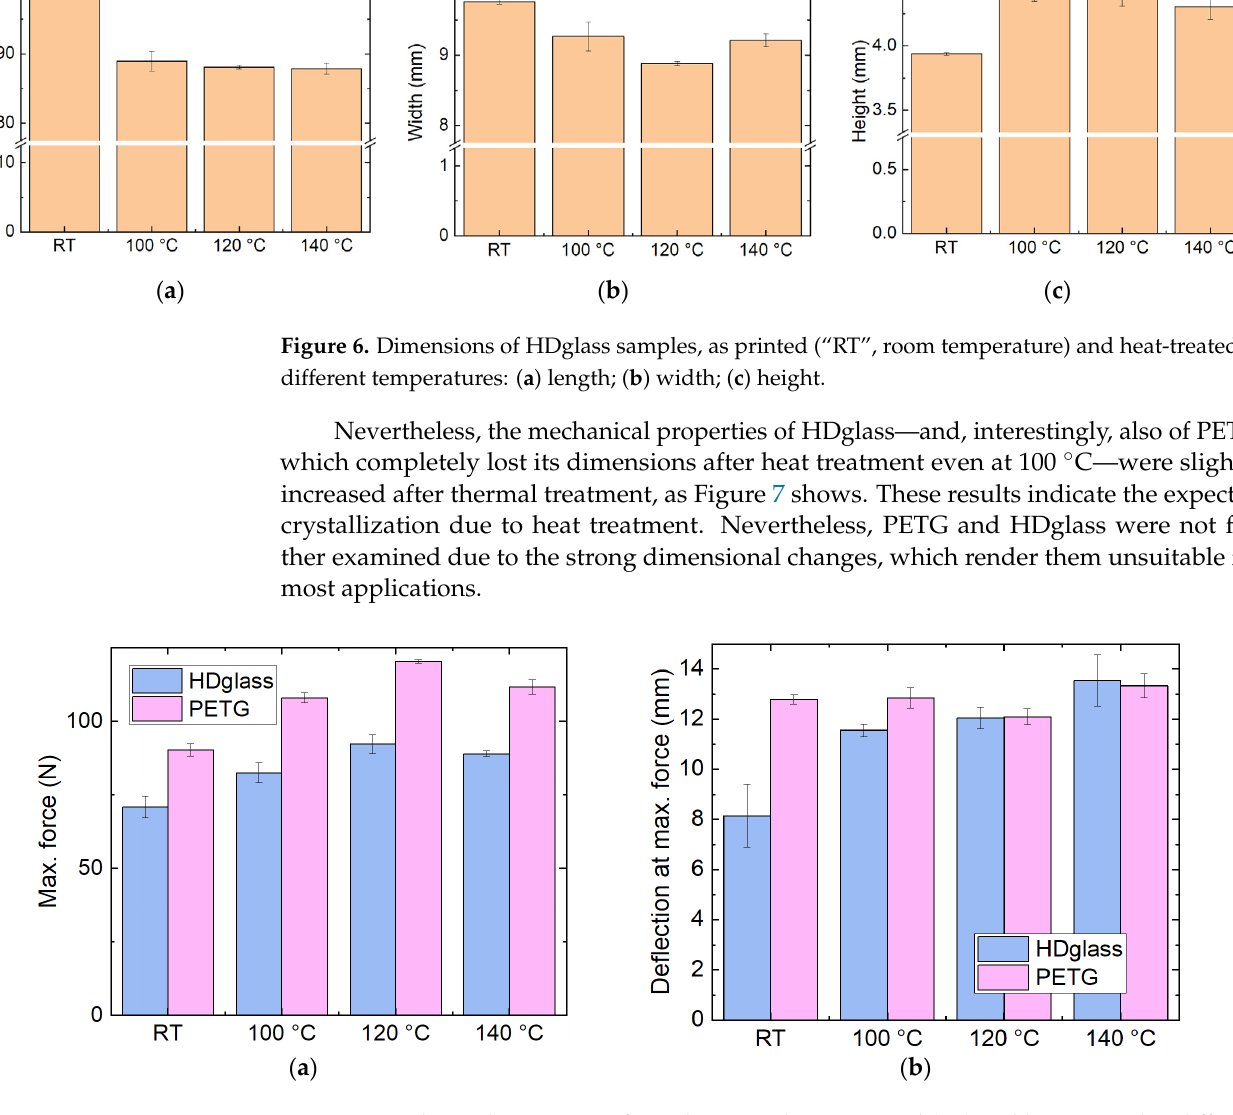
Figure 6. Dimensions of HDglass samples, as printed (“RT”, room temperature) and heat-treated at different temperatures: ( a ) length; ( b ) width; ( c ) height.